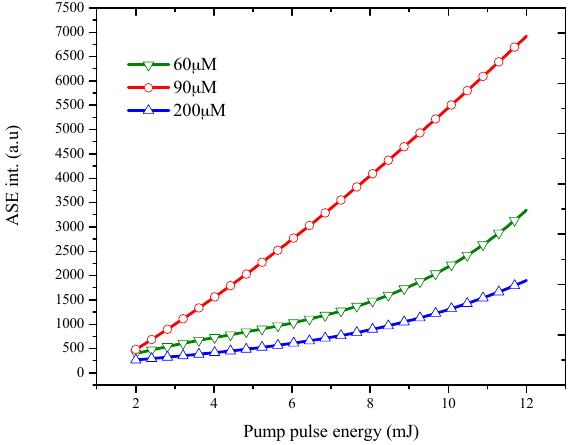
Figure 7. ASE intensity of PFO-co-pX dissolved in THF at different concentration for different pumping energy.